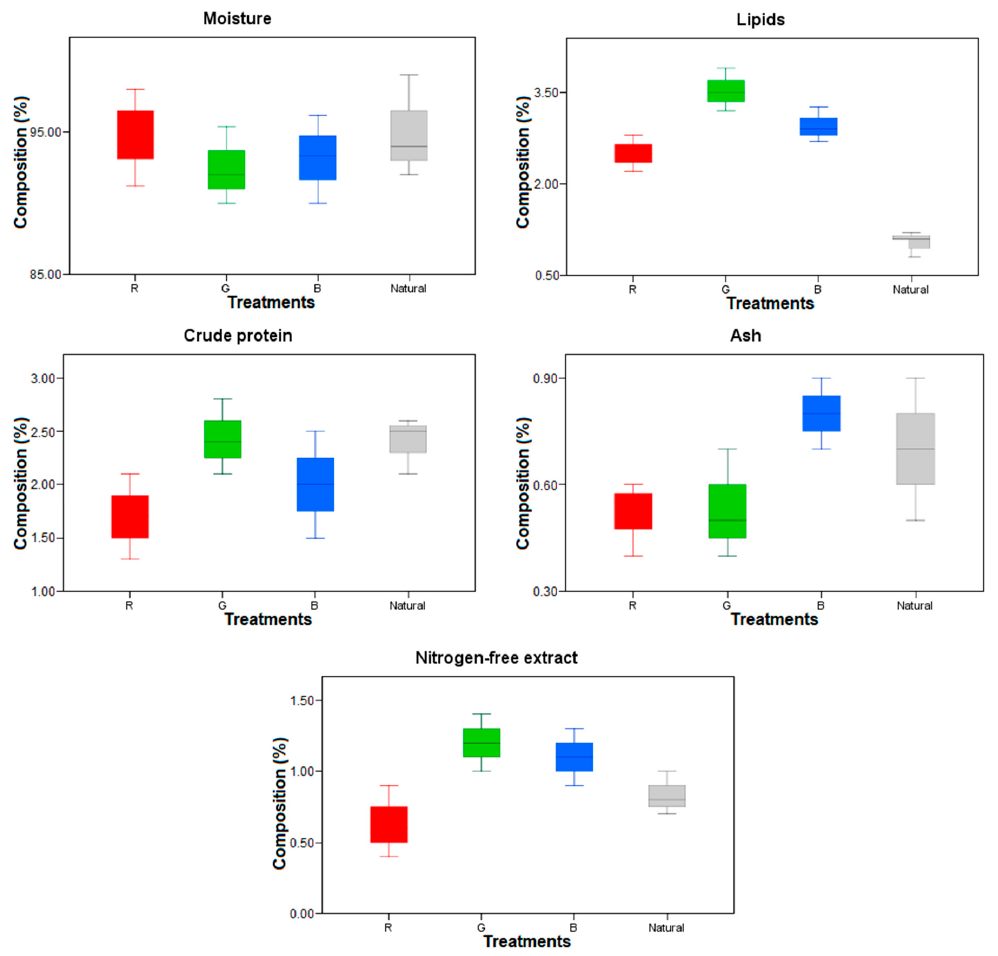
Figure 5. Box-and-whisker plots showing the nutritional composition of the biofloc